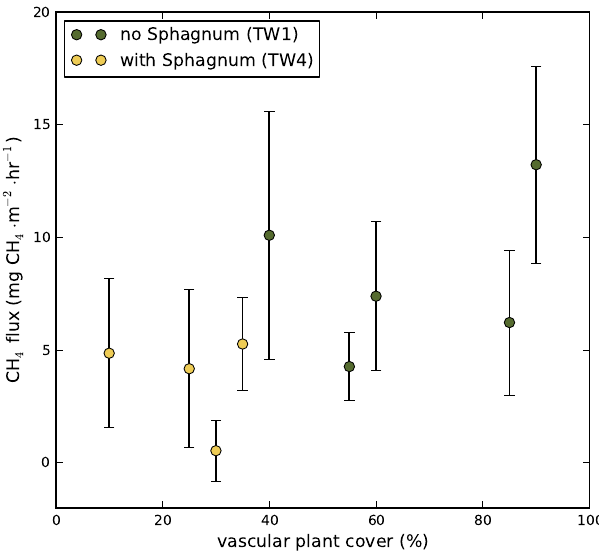
Fig. 6. Average methane fluxes of each measurement site, plot along its vascular plant cover. The error bars denote standard errors along all measurement days. Although there is a difference in vascular plant cover and methane flux between the two vegetation types TW1 and TW4, within each vegetation class there is no significant increase with vascular plant cover.